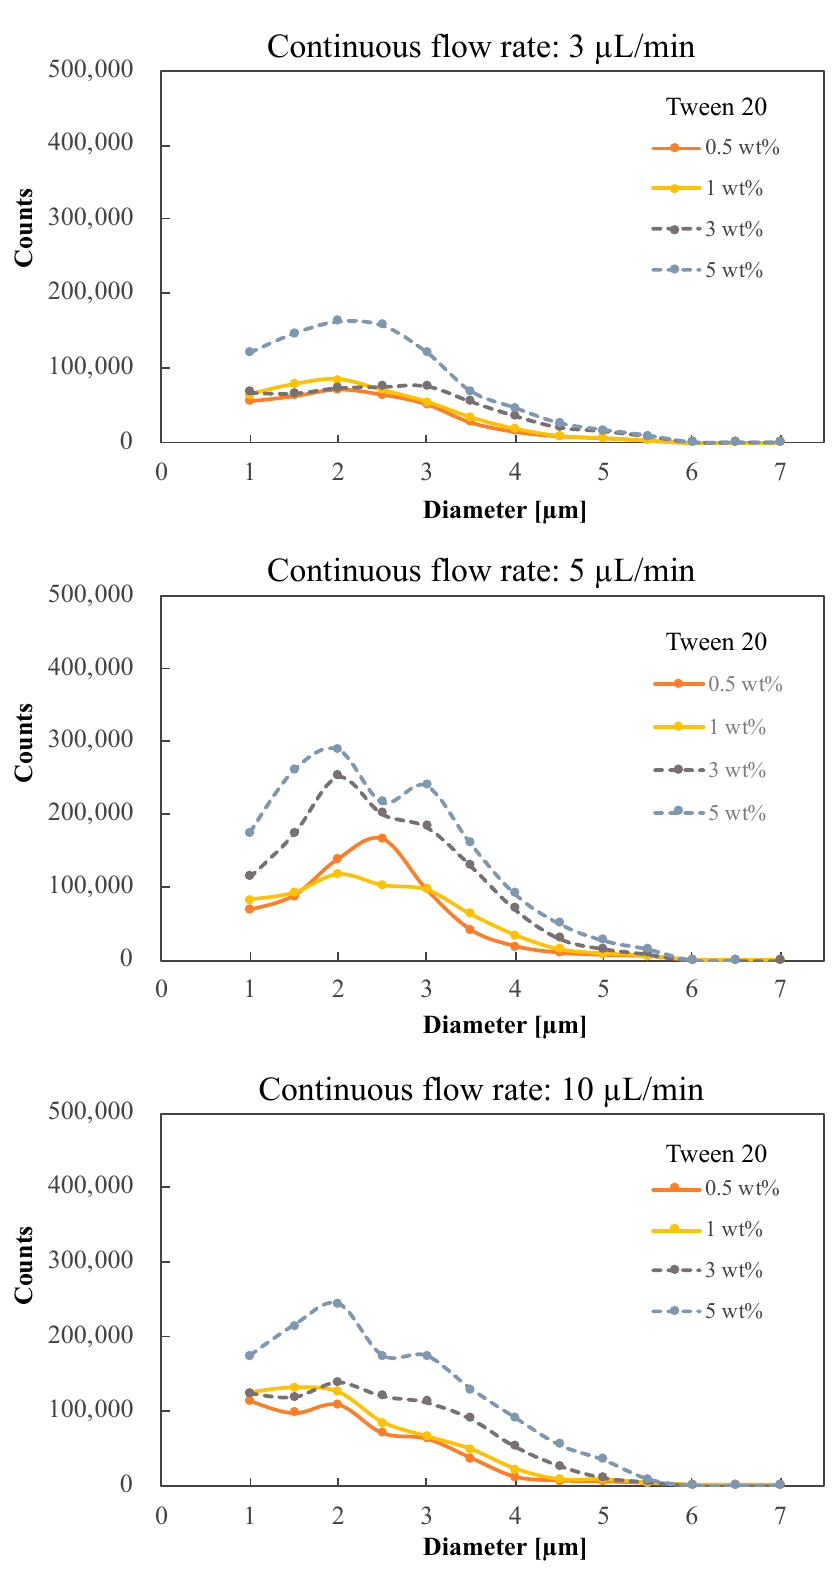
Figure 3. Number distribution of S-MDs with different surfactant concentrations and continuous flow rates in the dispersion flow.